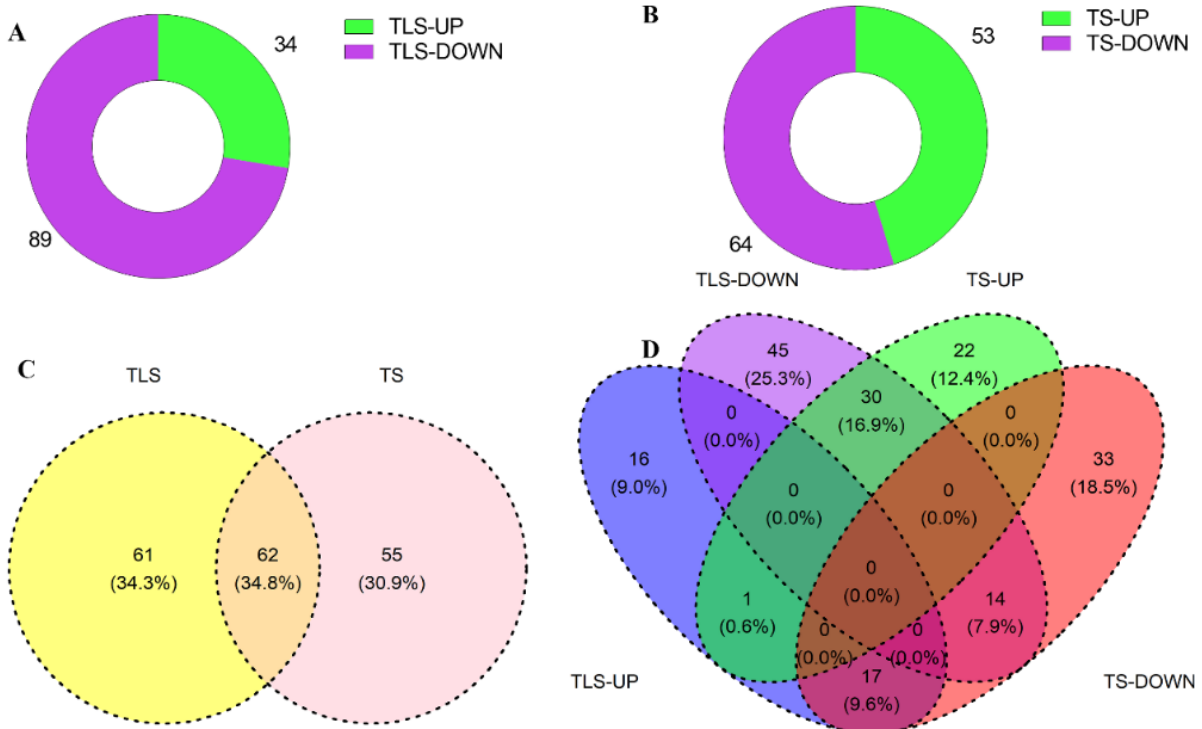
Figure 6. Statistical analysis of differential metabolism of spaceflight stress memory in different growth stages of rice. ( A ) represents the different metabolites at the TLS; ( B ) represents the different metabolites at the TS; ( C ) represents the Venn diagram of the different metabolites at the TLS and the TS; ( D ) represents the Venn diagram of the increase or decrease in the concentration at the TLS and the TS. TLS and TS stand for three-leaf stage and tillering stage, respectively.